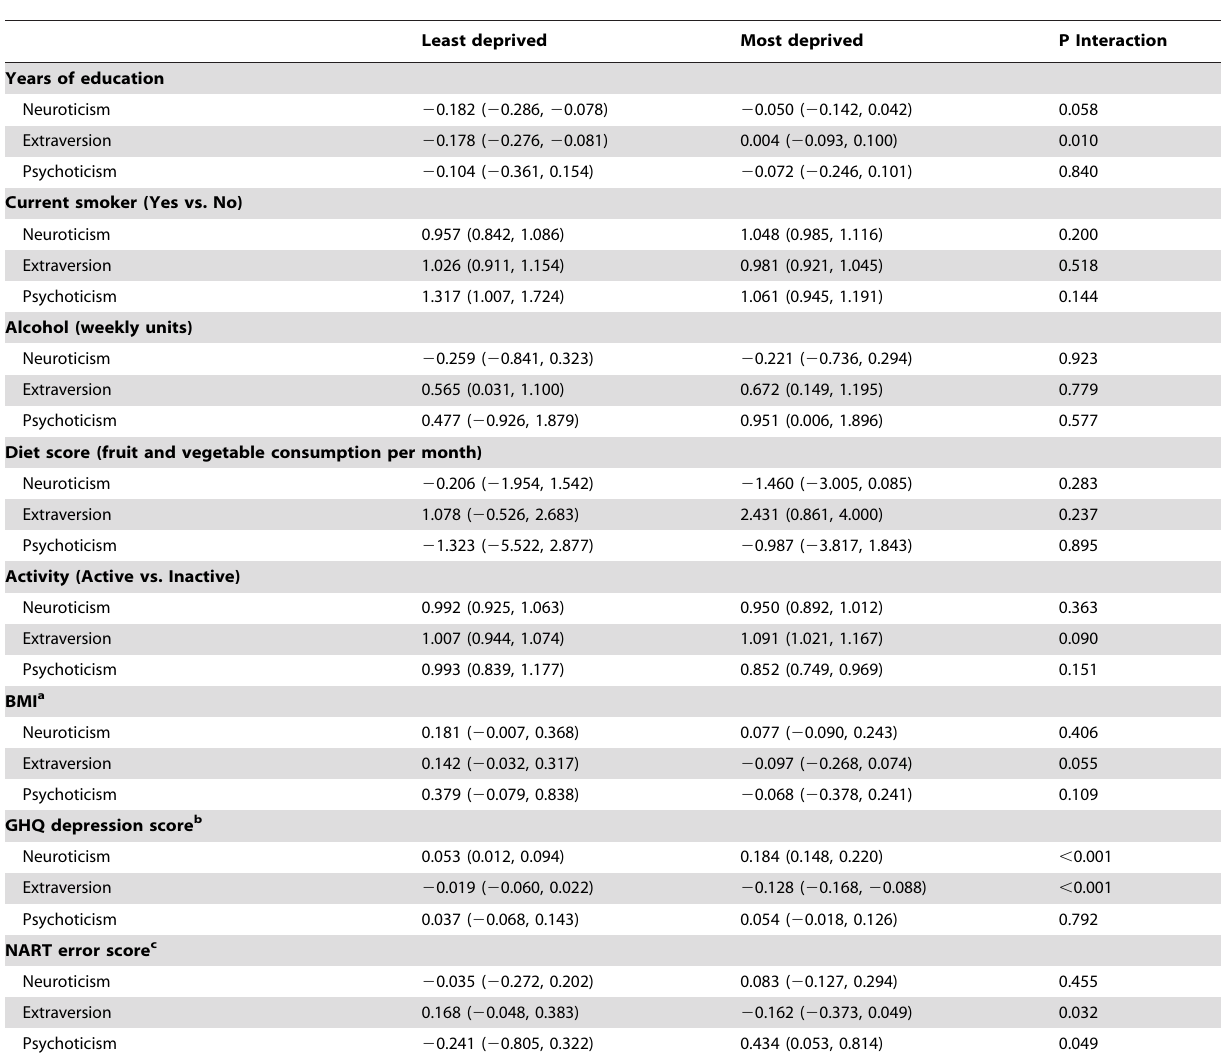
Table 3. Associations between personality traits and health behaviours in affluent and deprived groups, and their interactions.